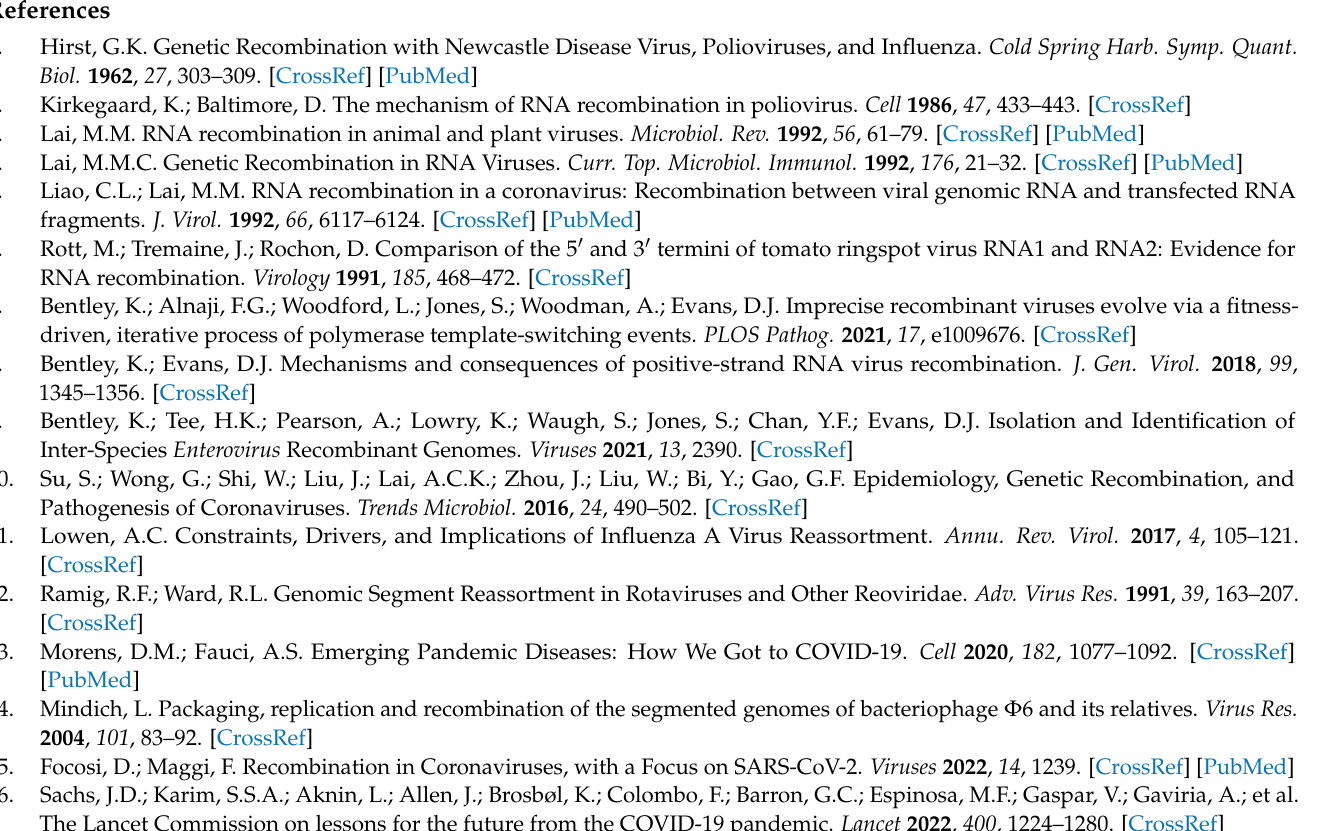
Figure 12. Furin site insertion “PRRAR” into SARS-CoV-2 from Bat_RaTG13. Based on Gallaher (2020).